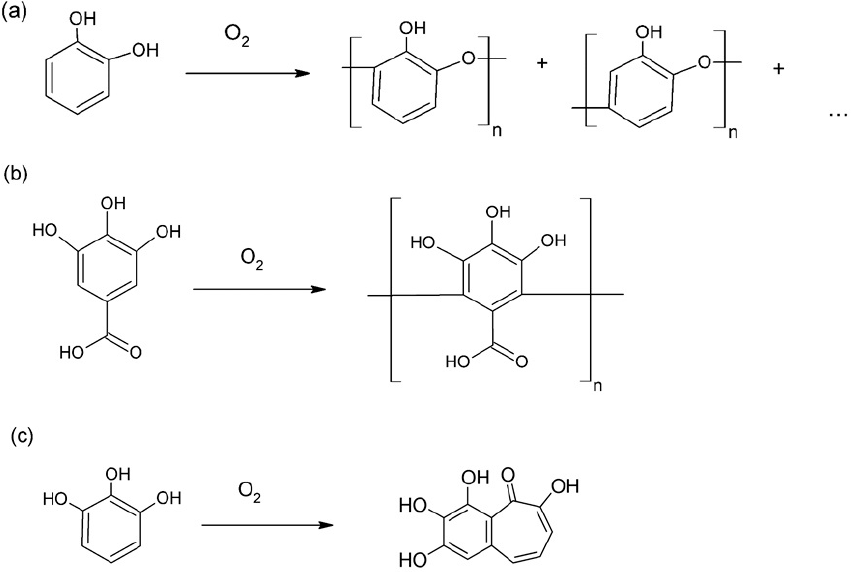
Figure 4. Enzymatic polymerization of ( a ) catechol; ( b ) gallic acid and dimerization of ( c ) pyrogallol by the commercial laccase from M. thermophila .